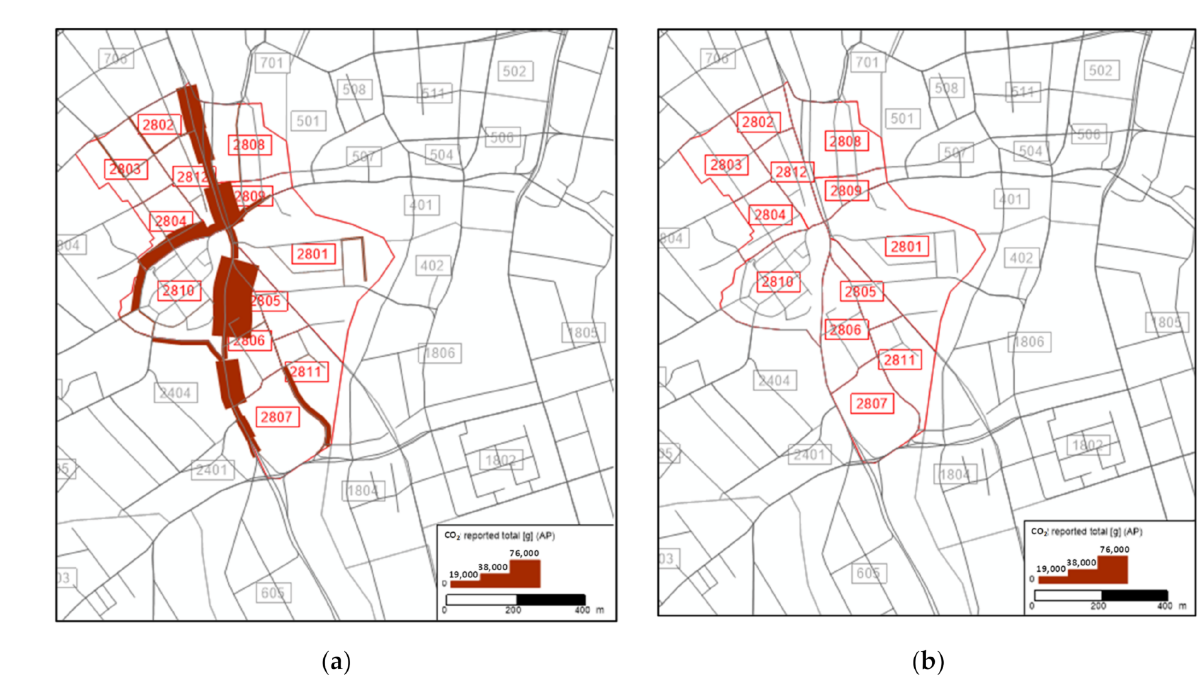
Figure 13. The assessment of CO 2 total [g] (measure from Group 1) for scenario W0 and optimal scenario (W3)—analysis for the central areas of the city: ( a ) measures for scenario W0; ( b ) measures for scenario